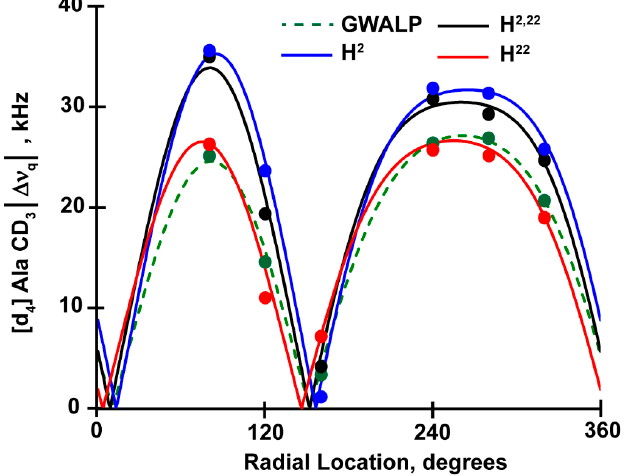
Figure 4. Quadrupolar wave plot for oriented GWALP23 family peptides with histidine residues H2 and/or H22 in DLPC lipid bilayers.